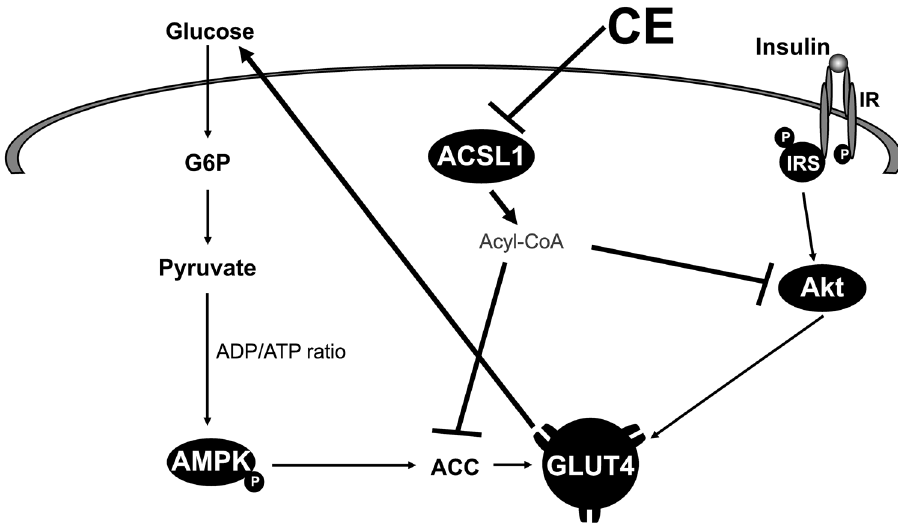
Figure 6. Outline of the mechanisms for the stimulation of glucose metabolism by cinnamon. Using 3T3- L1 adipocytes, we demonstrated that CE downregulates ACSL1 to activate the AMPK signaling pathway that stimulates glucose uptake and suppresses